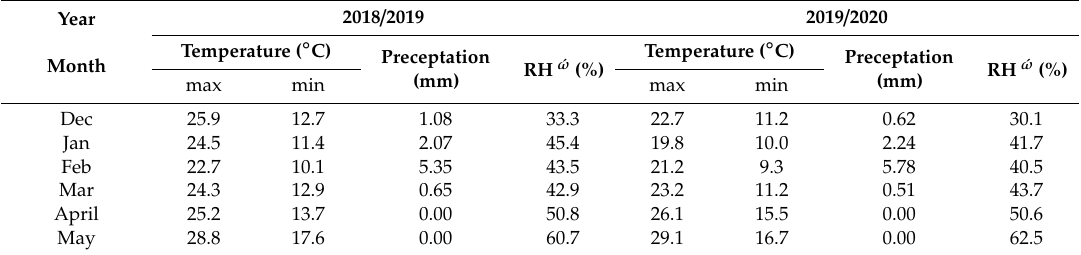
Table 5. Meteorological data for Sakha Station during 2018 / 2019 and 2019 / 2020 growing